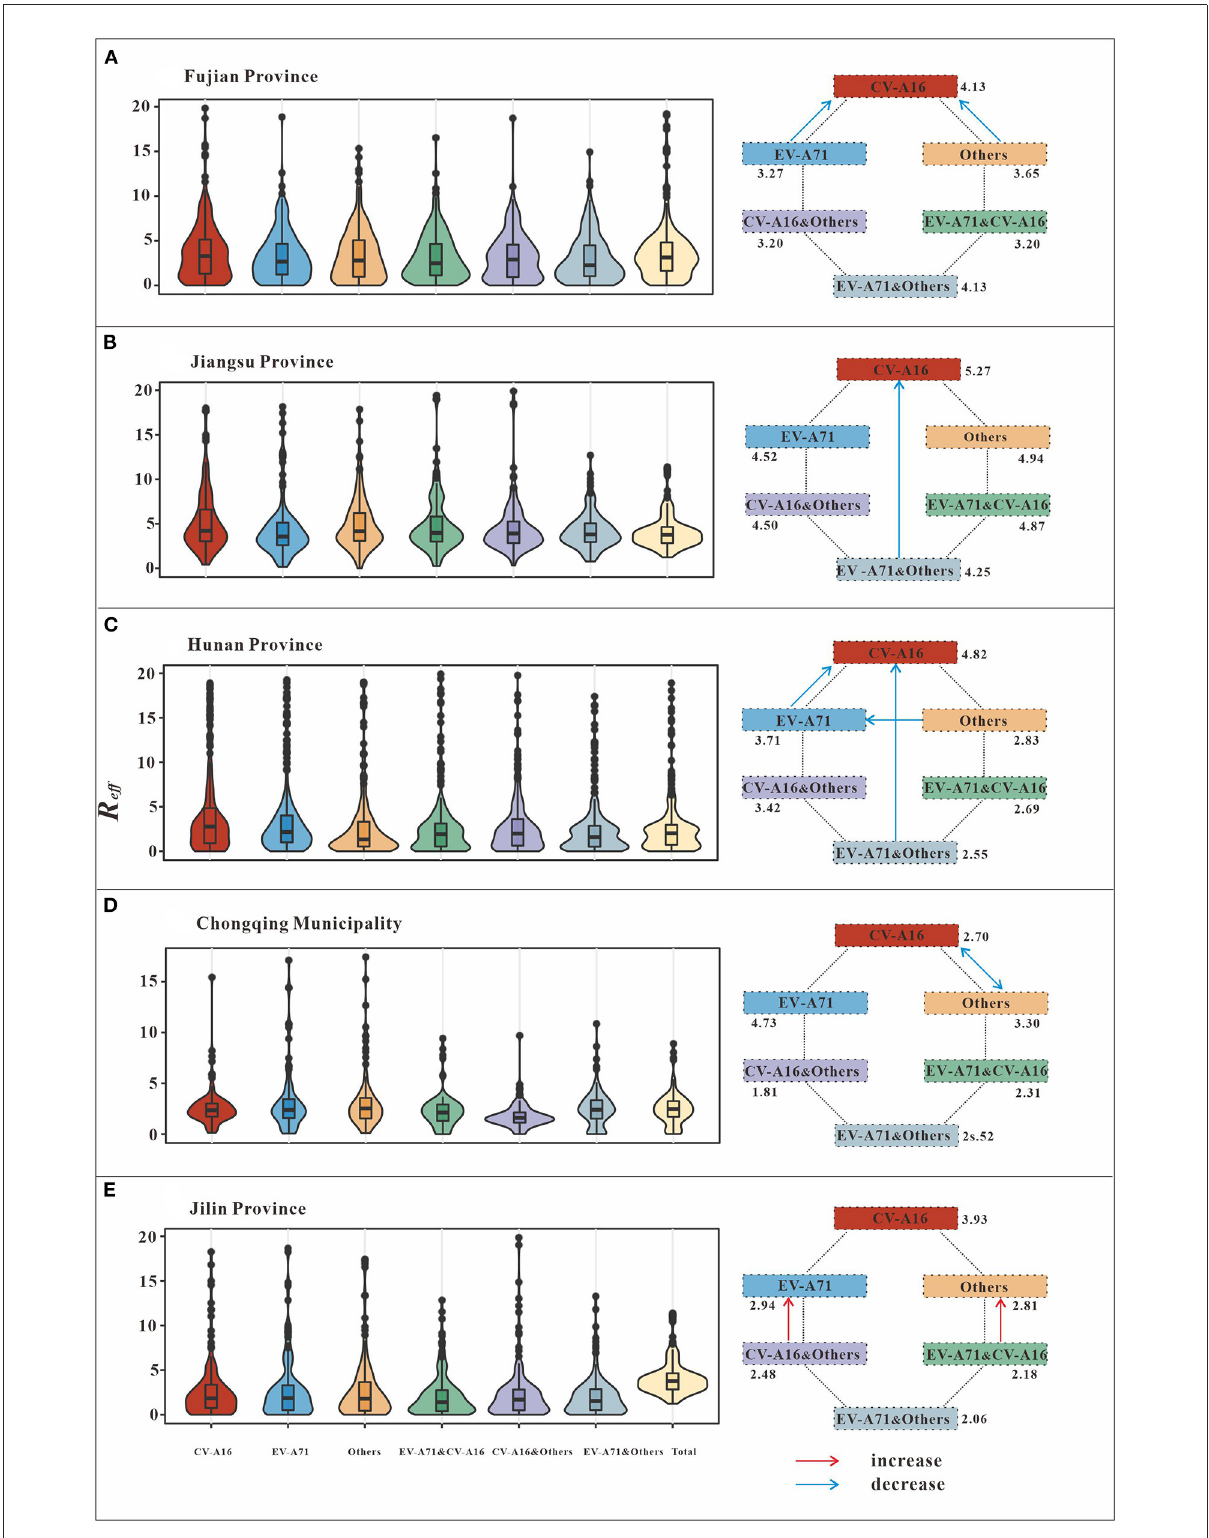
FIGURE4 Schematic diagram of the interaction among different pathogens of HFMD. (A) (Fujian Province) indicates EV-A71 has negative inhibition on CV-A16, while others have negative inhibition on CV-A16. (B) (Jiangsu Province) shows that EV-A71 and others are present together to produce negative inhibition of CV-A16. (C) (Hunan Province) indicates EV-A71 has negative inhibition on CV-A16. There is negative inhibition of CV-A16 when EV-A71 and others are transmitted simultaneously. In addition to this, others have negative inhibition on EV-A71. (D) (Chongqing Municipality) indicates a bidirectional negative inhibition between CV-A16 and other. (E) (Jilin Province) indicates that when all-pathogen co-transmission, EV-A71, and other enterovirus get some increase in